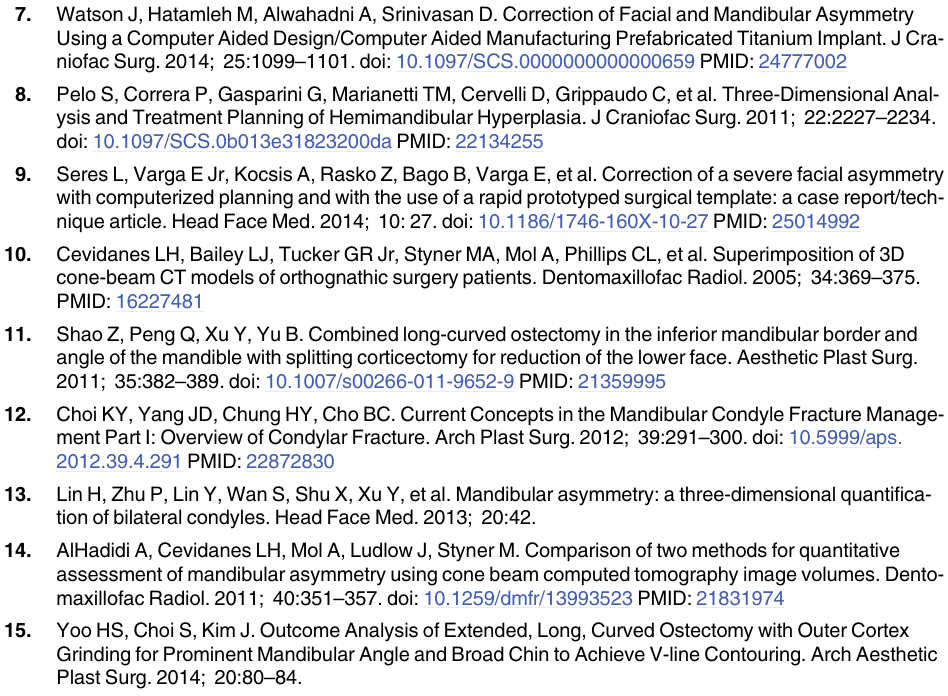
PLOS ONE | DOI:10.1371/journal.pone.0161601 August 29, 2016 10 /